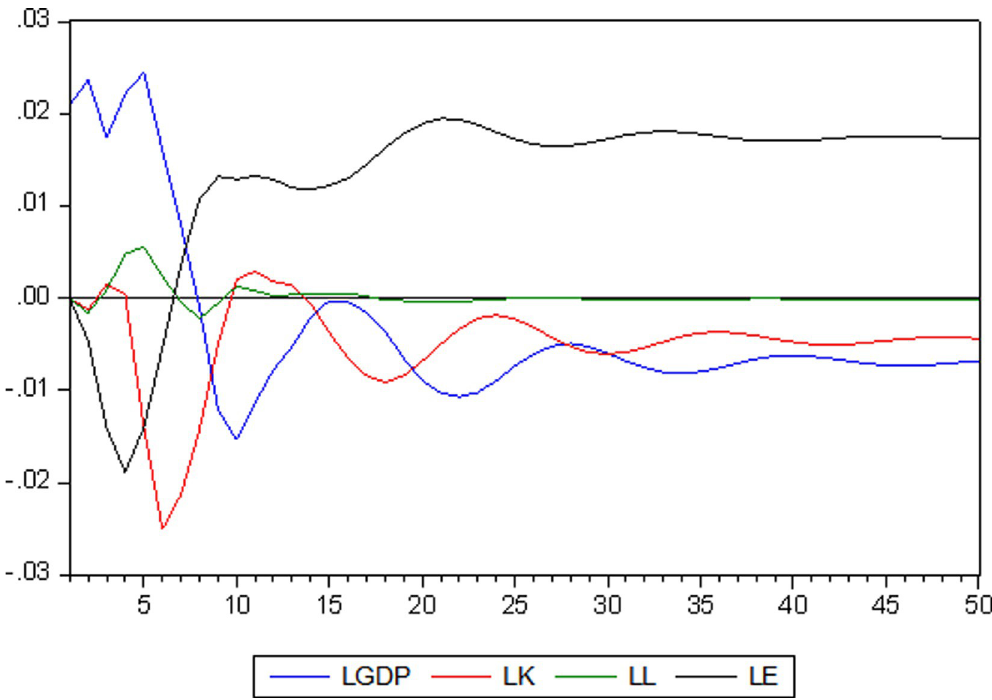
Fig 8. Impulse response results of LGDP affected by the four